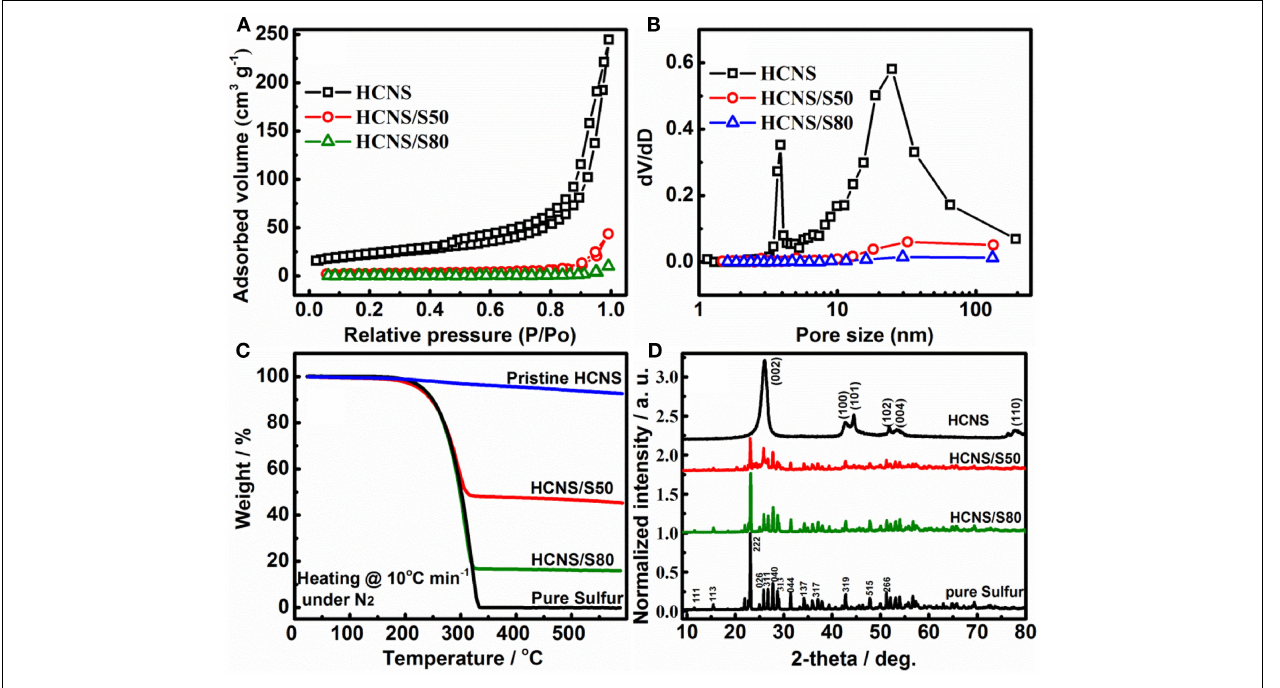
composites were normalized over the intensity of the (222) peak of the S; the XRD pattern of HCNS was normalized over its maximum intensity (002) peak for comparison.